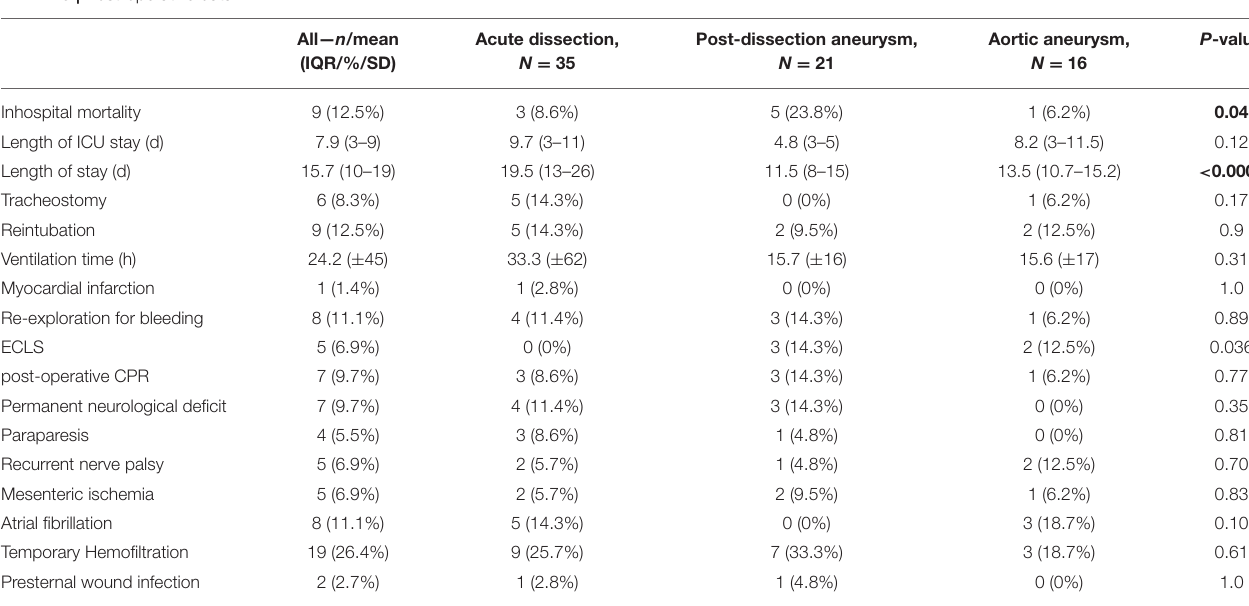
TABLE 3 | Post-operative